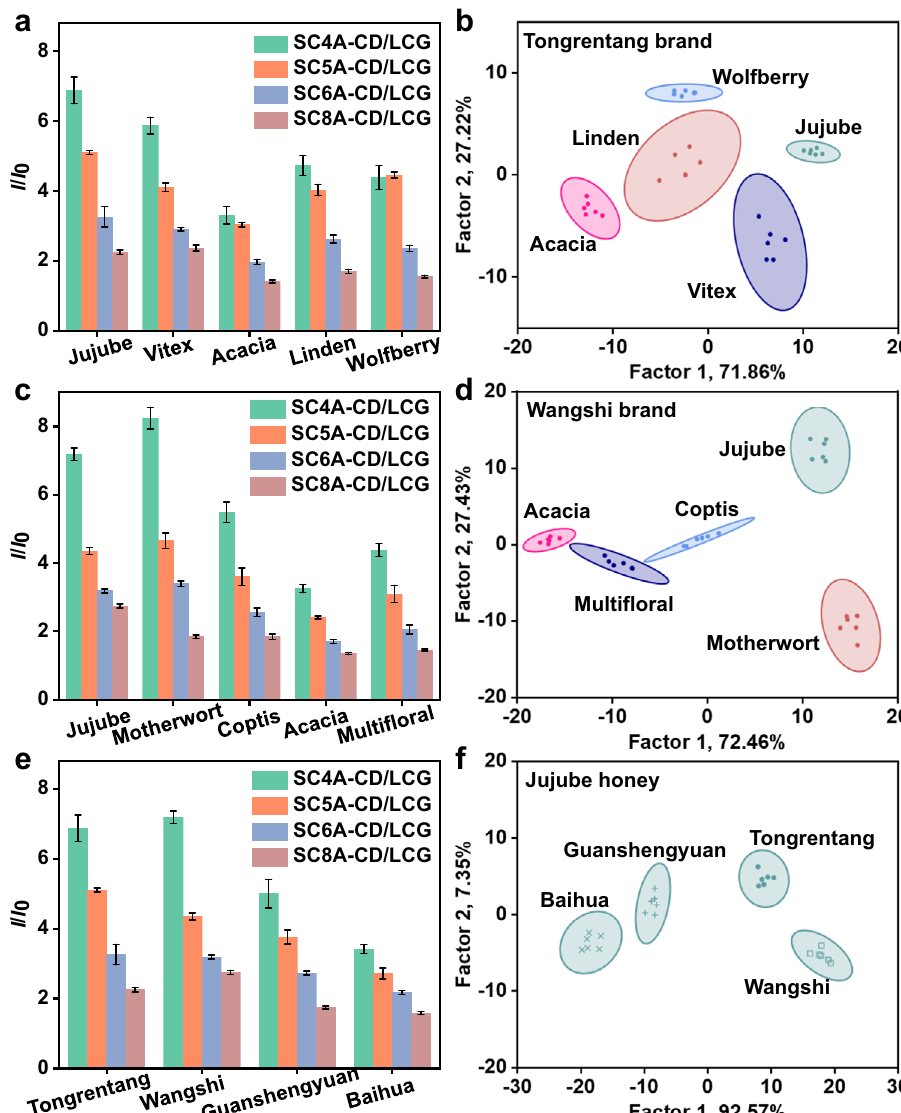
Fig. 8 Discrimination of honey samples from different fl ora origins and brands. a Fluorescence response patterns and b canonical score plot for Tongrentang brand samples. c Fluorescence response patterns and d canonical score plot for Wangshi brand samples. e Fluorescence response patterns and f canonical score plot for jujube honey samples (3.0 mg/mL for each honey sample). Pattern recognition of honey samples using SA11 ([CA] = [CD] = 1.0 μ M, [LCG] = 1.0 μ M). Canonical score plots for the two factors of simpli fi ed fl uorescence response patterns obtained from LDA with 95% con fi dence ellipses. Error bars in a , c , e represent mean ± s.d. ( n = 6 independent experiments). The order of colored symbols from top to bottom in the legend corresponds to the column order of histogram from left to right in a , c , e